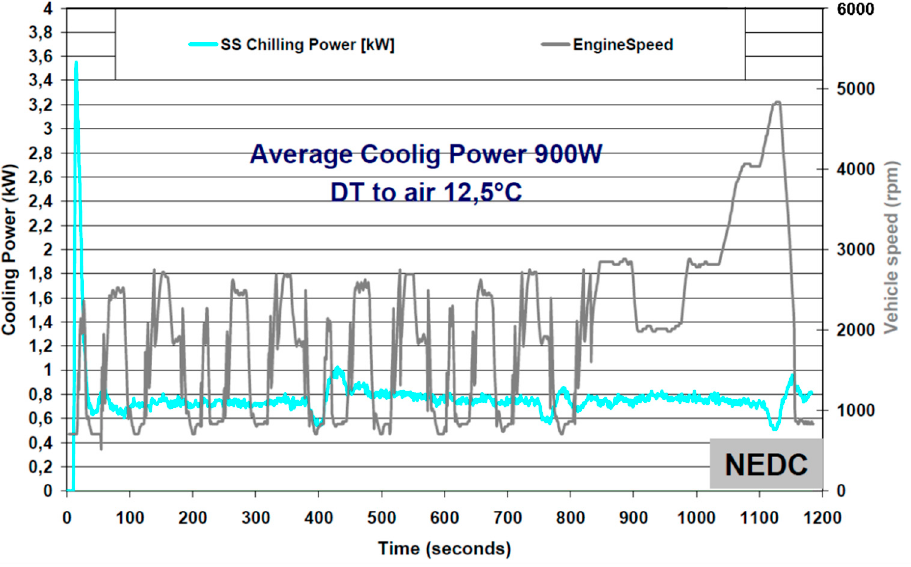
Figure 10. Cooling power at various engine speeds [8].